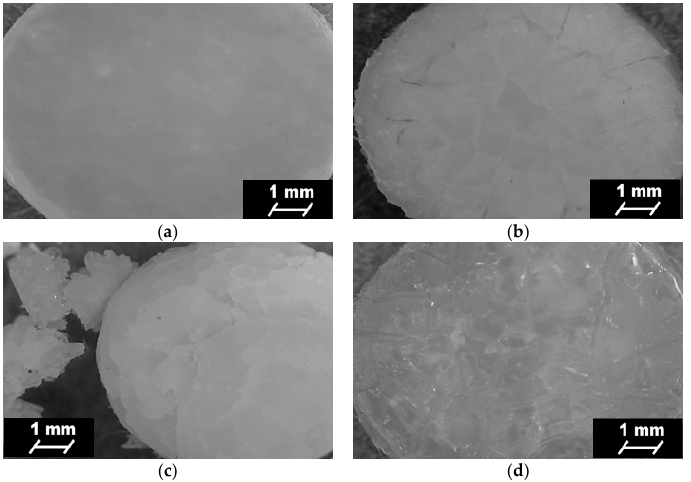
Figure 7. Optical microscope images of PURs before ( a ) and after 15 days of short-term interactions study performed in the selected environments: basic ( b ); acidic ( c ); and oxidative ( d ).